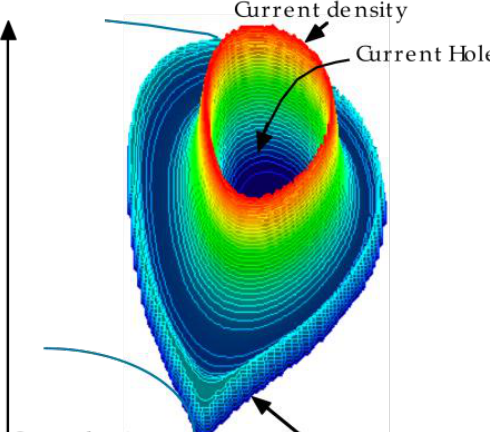
Figure 17. Current Hole equilibrium in JT-60U observed by Fujita